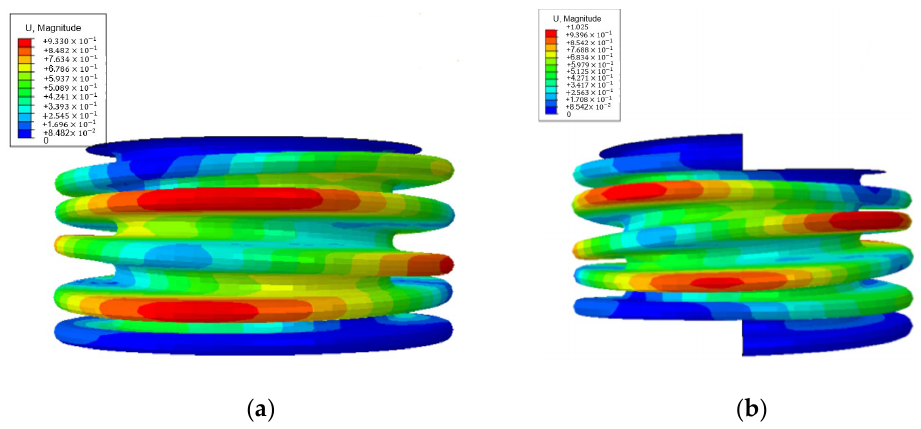
Figure 8. Plane instability of the two types of bellows (convolution number was less than 10); ( a ) buckling mode of toroid bellows and ( b ) buckling mode of spiral bellows.